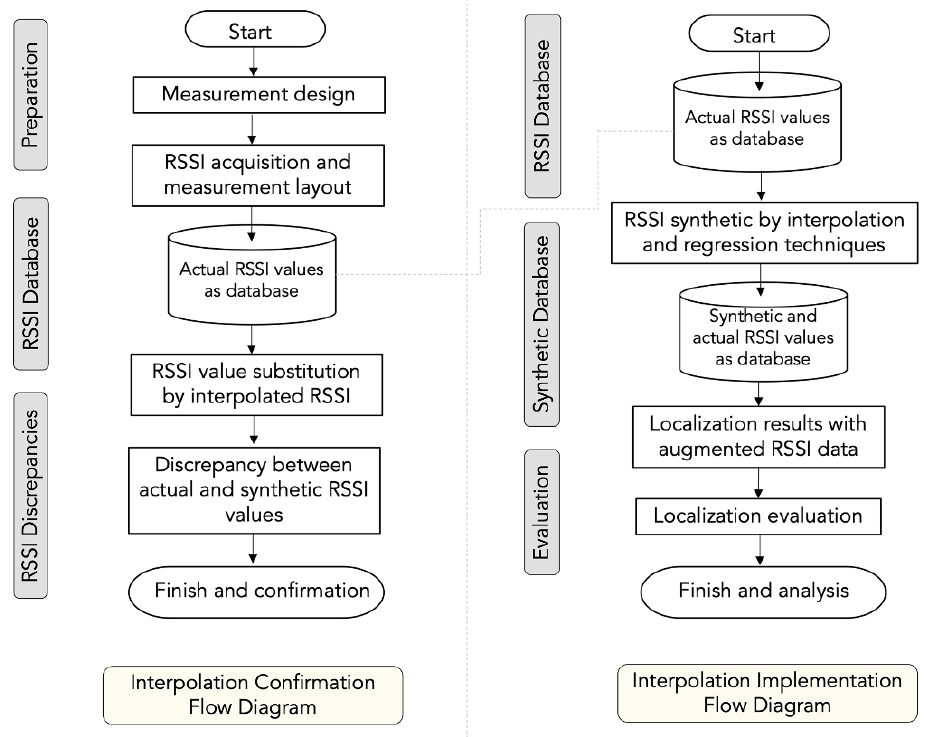
Figure 9. Flowchart of the research